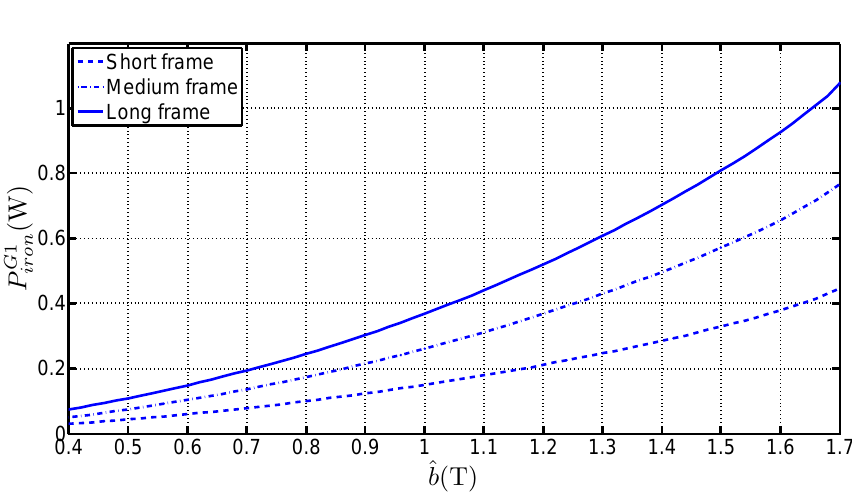
Figure 3. Variations of P iron with ˆ b for the three frames and G1